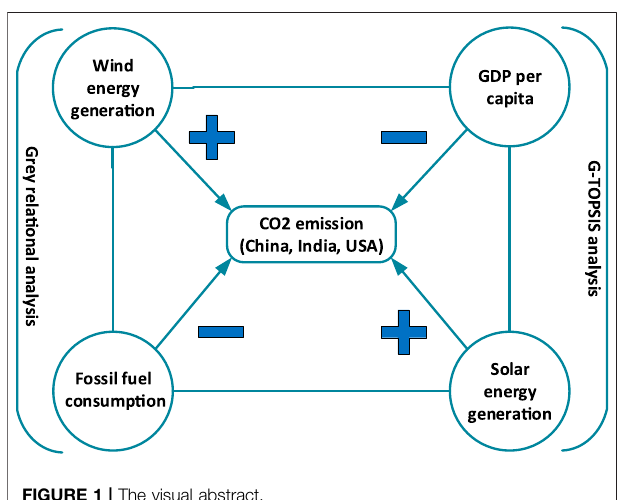
FIGURE 1 | The visual